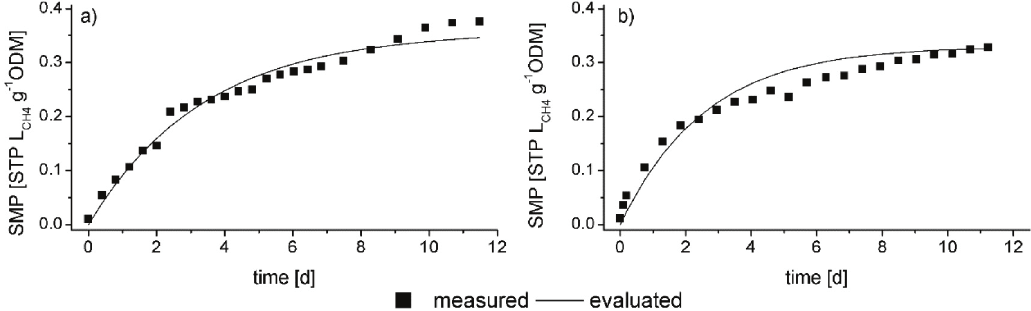
Fig. 2 – Fitting results: a) MS, b)